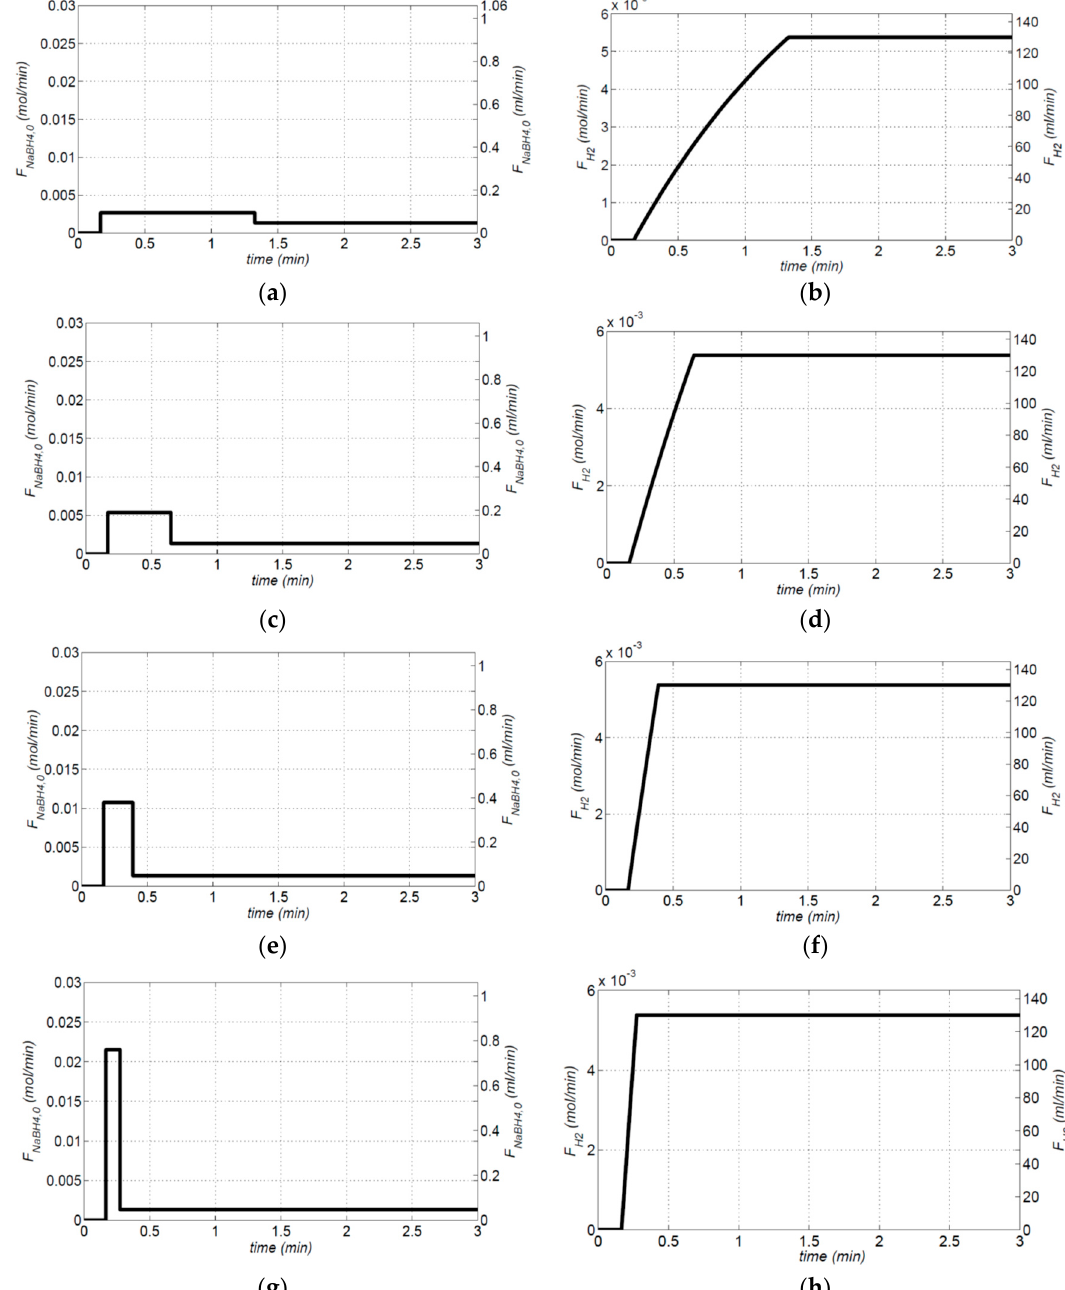
Figure 8. Feed flowrate and hydrogen generation flowrate of the hydrogen-on-demand system with a combined pulse and step function of feed NaBH 4 flowrate and pulse flowrate to normal feed flowrate ratio at 2 ( a ) and ( b ), 4 ( c ) and ( d ), 8 ( e ) and ( f ), 16 ( g ) and ( h ) with τ = 1.67 min.